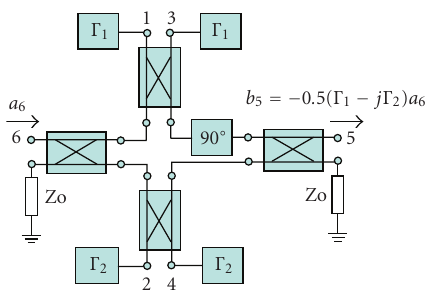
Figure 3: The simplified block diagram of a multiport modulator.